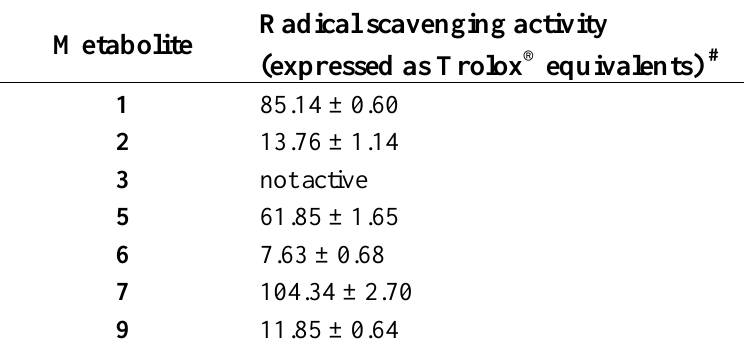
Table 2. Hydroxyl radical-scavenging activity (CL) of evaluated